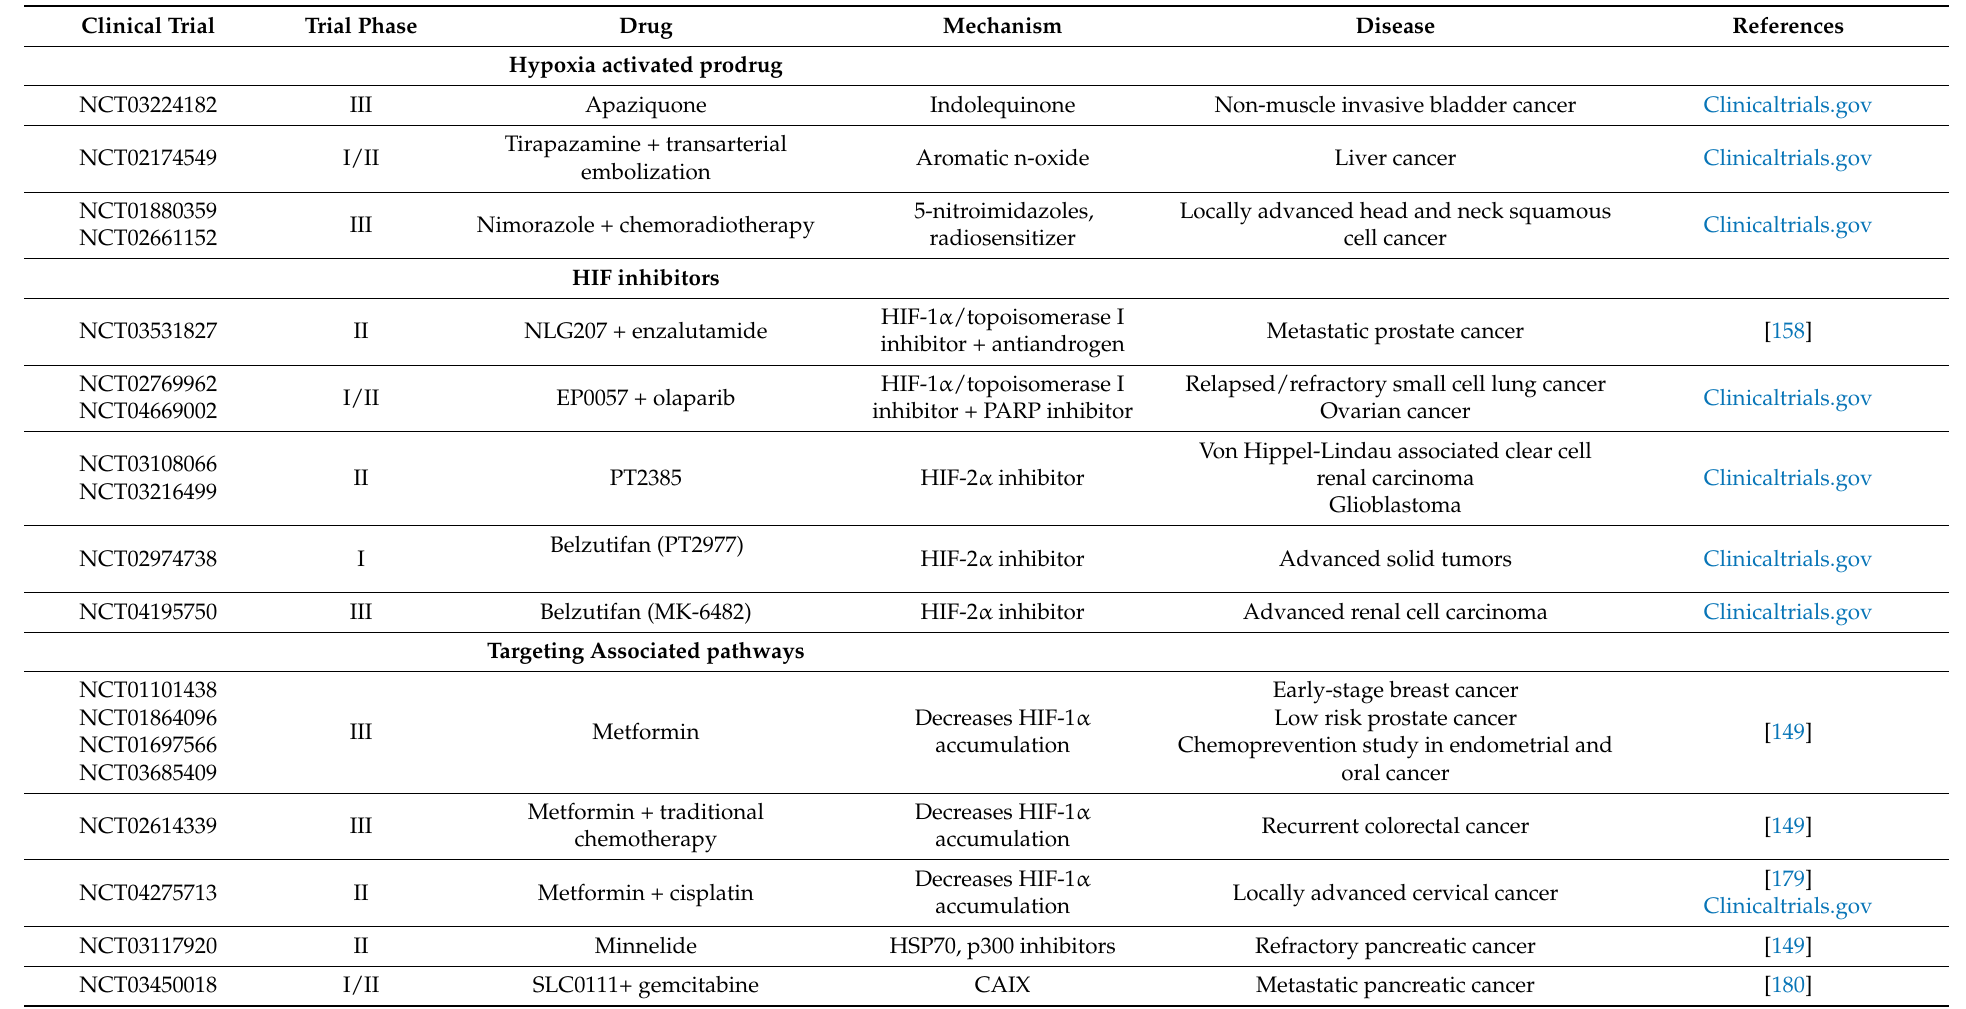
Table 1. Ongoing clinical trials targeting and evaluating hypoxia in the tumor